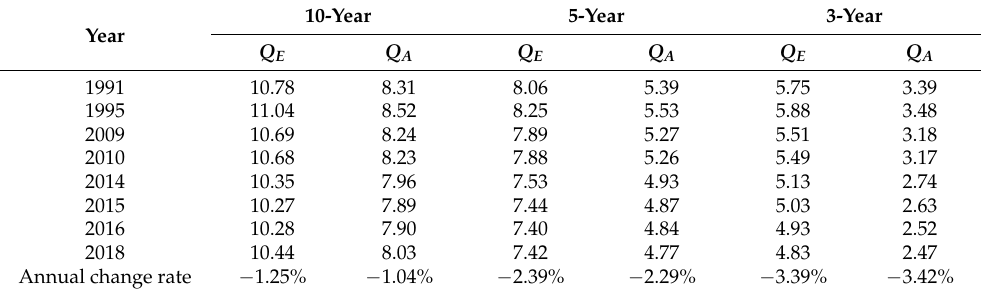
Table 4. Drainage coefficient under discharging 3-day rainfall in 4 days with different return periods